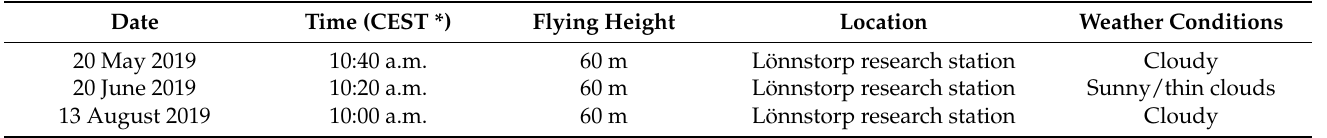
Table 2. List of flights used to study the influence of atmosphere.